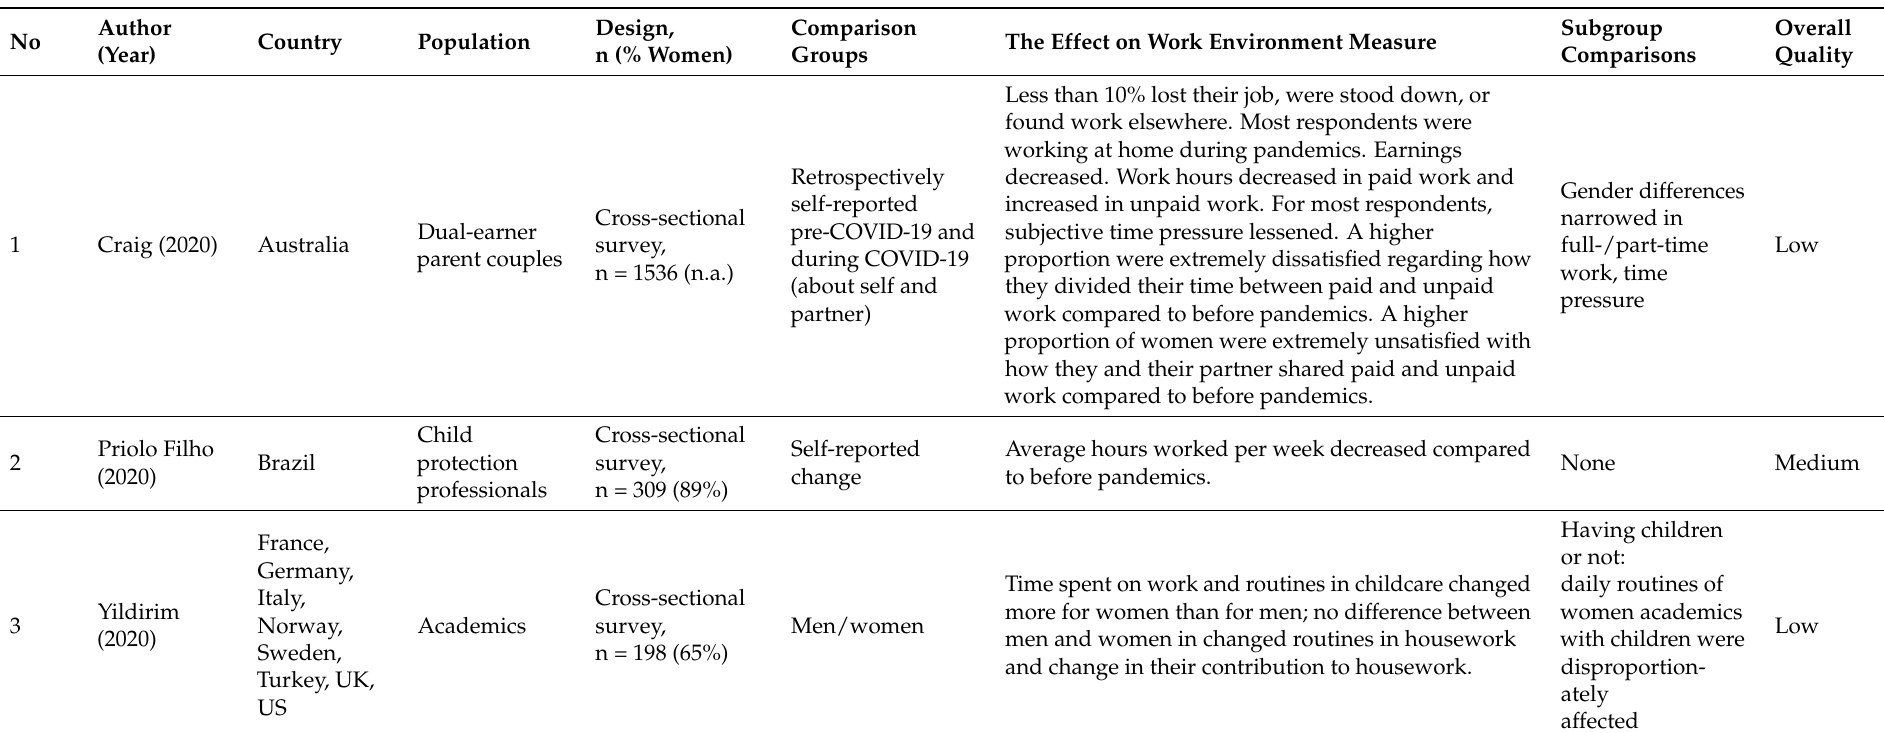
Table 5. Overview of quantitative studies assessing how the work environment in organizations outside the healthcare sector is affected by an epidemic or pandemic (research question 1). All studies are in the context of